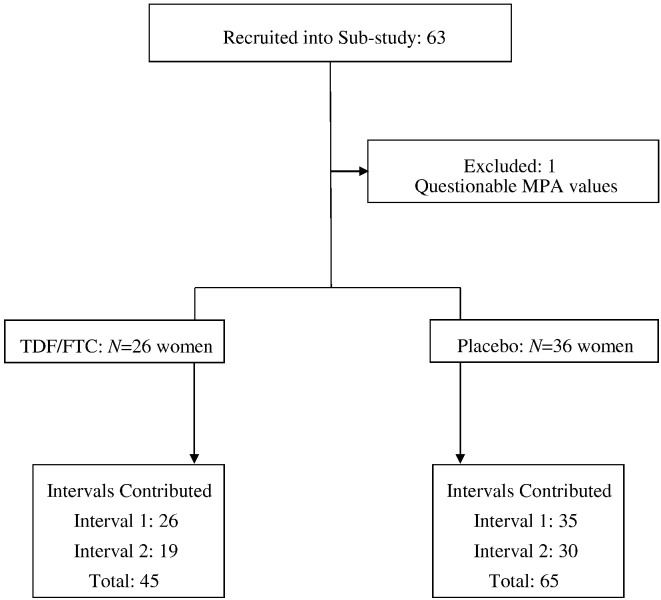
Study population and intervals contributed to analyses.